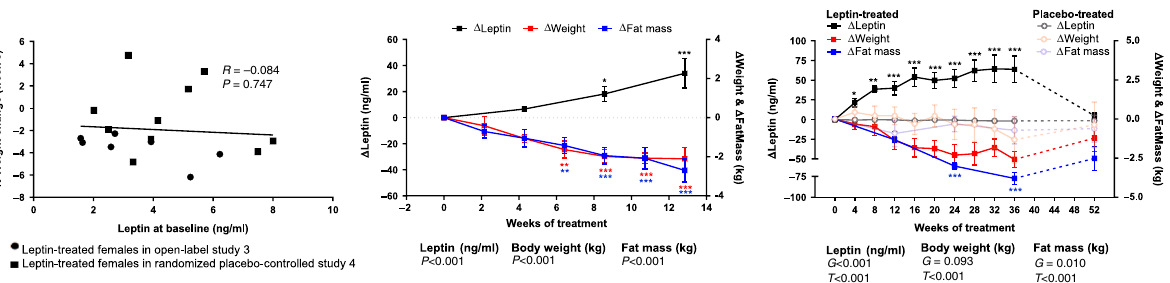
Fig. 2 Leptin effects on weight and fat mass. a Cross-over study of lean subjects during 72-h fed state, fasting + placebo and fasting + leptin (study 1; n = 13). Left: baseline leptin levels in each admission. Center: % weight change at the end of each admission. Right: correlation of baseline leptin with % weight change at the end of each admission. Numbers above bars correspond to subject ID. P values of unpaired t test between lean men (LM) vs lean women (LW) and of correlations are reported; R , correlation coef fi cient. b Cross-over study of LM, LW, and obese men (OM) in 72-h fasting treated with escalating leptin doses (study 2; n = 15). Left: baseline leptin levels in each admission, Center: % weight change at the end of each admission. Right: correlation of baseline leptin with % weight change at the end of each admission. Numbers above bars correspond to subject ID. P values from one-way ANOVA, from post hoc Bonferroni test between LM vs LW vs OW and from correlations are reported. c Open-label (study 3; n = 7) and placebo-controlled long-term leptin treatment study (study 4; n = 19 (leptin = 10; placebo = 9)) in women with mild hypoleptinemia. Left: correlation of baseline leptin with % weight change after 8 weeks of leptin treatment. Subjects of study 3 were combined with leptin-treated subjects of study 4 in one analysis. Center and right: changes of leptin, body weight, and fat mass from baseline ( Δ = change from baseline at each timepoint). In study 4, dashed lines correspond to the washout period after 36 weeks of study. In study 3, P values ( P ) for time effect (i.e., days of treatment) and in study 4, P values of G (group: leptin or placebo), T (time: weeks of treatment), and G * T interaction of mixed models adjusted for baseline are reported. By P <0.05 (study 3) and G * T <0.05 (study 4), post hoc Bonferroni test was performed (only signi fi cant results are reported). One, two, or three asterisks indicate P <0.05, <0.01, or <0.001 for the speci fi c timepoint vs baseline in study 3 and for leptin vs placebo in the speci fi c timepoint in study 4. Correlations were performed with Pearson ’ s or Spearman ’ s correlation test. Data are presented as means±SEMs. Exact P values : b , left: leptin at baseline dose 0.3mg/kg = 0.003×10 − 1 ; leptin at baseline dose 0.3mg/kg LM vs LW = 0.003×10 − 1 . c Center : leptin = 0.003×10 − 1 ; weight = 0.001×10 − 3 ; fat mass = 0.002×10 − 5 ; leptin post hoc test at 8 = 0.031 and at 13 weeks = 0.003×10 − 1 . Weight post hoc test at 6 1/2 weeks = 0.002, at 8 1/2 weeks = 0.001×10 − 1 , at 11 weeks = 0.001×10 − 1 , and at 13 weeks = 0.001×10 − 1 . Fat mass post hoc test at 6 1/2 weeks = 0.002, at 8 1/2 weeks = 0.002×10 − 2 , at 11 weeks = 0.005×10 − 3 , and at 13 weeks = 0.004×10 − 4 . c , Right : leptin G = 0.005×10 − 2 ; T = 0.007×10 − 5 ; G * T = 0.002× 10 − 5 ; body weight T = 0.007×10 − 5 ; fat mass T = 0.009×10 − 5 ; G * T = 0.001×10 − 2 ; leptin post hoc test at 4 weeks = 0.039; at 8 weeks = 0.001;